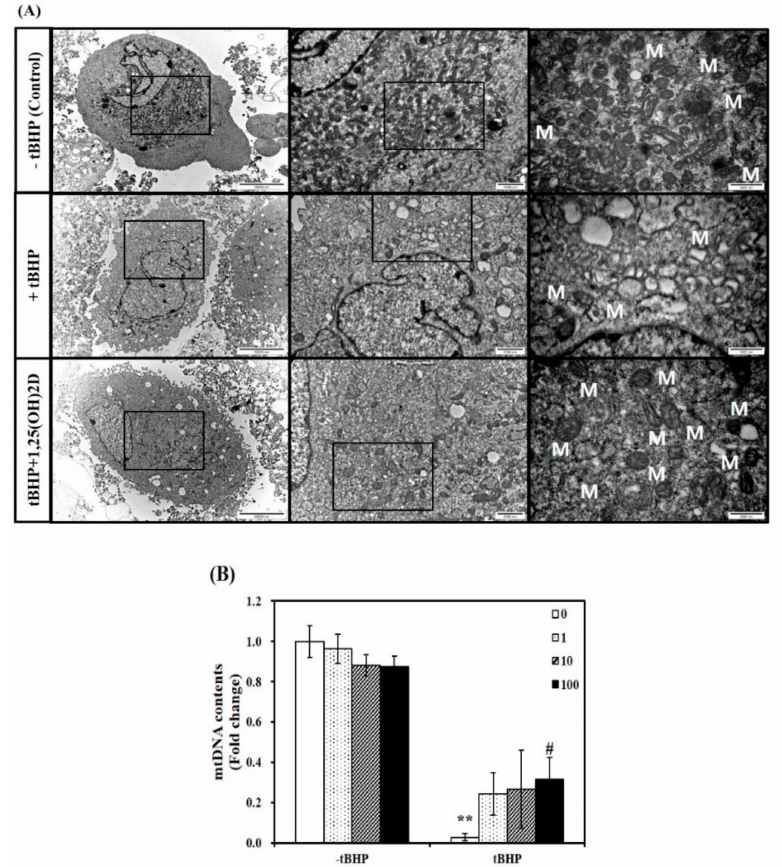
Figure 2. Influence of 1,25-dihydroxyvitamin D (1,25(OH)2D) on mitochondrial morphology and mitochondrial DNA (mtDNA) contents. Transmission electron microscopy (magnification of 7000, 20,000, and 50,000; scale bars = 10, 2, and 1 µ m) ( A ). M demonstrates the position of mitochondria. The mtDNA contents were quantified by qRT-PCR ( B ). Results are expressed as mean ± SEM from two independent experiments ( n = 6 per group). ** p < 0.01 compared to vehicle control. # p < 0.05 compared to tBHP control. Control (-tBHP), vehicle-treated C2C12 muscle cells; + tBHP, 0.1 mM tertiary butyl-hydrogen peroxide-treated myotubes; tBHP + 1,25(OH)2D, pretreatment with 0.1 mM tBHP following 1,25(OH)2D incubation (100 nM, 24